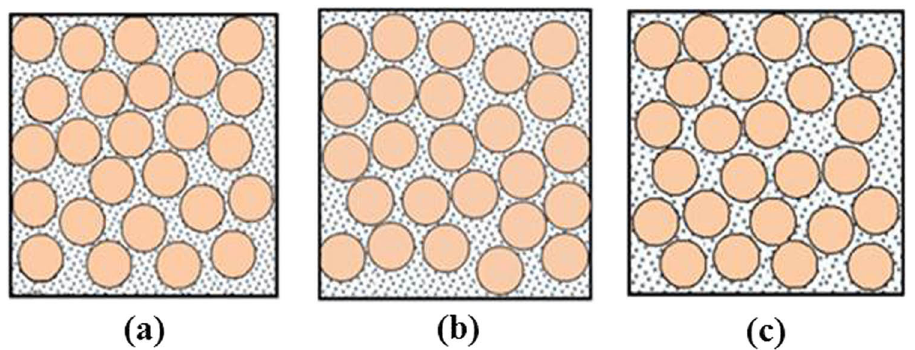
Figure 3: Random arrangement of 25 carbon nano fi bers with a uniform radius. ( a ) case 1; ( b ) case 2; ( c ) case